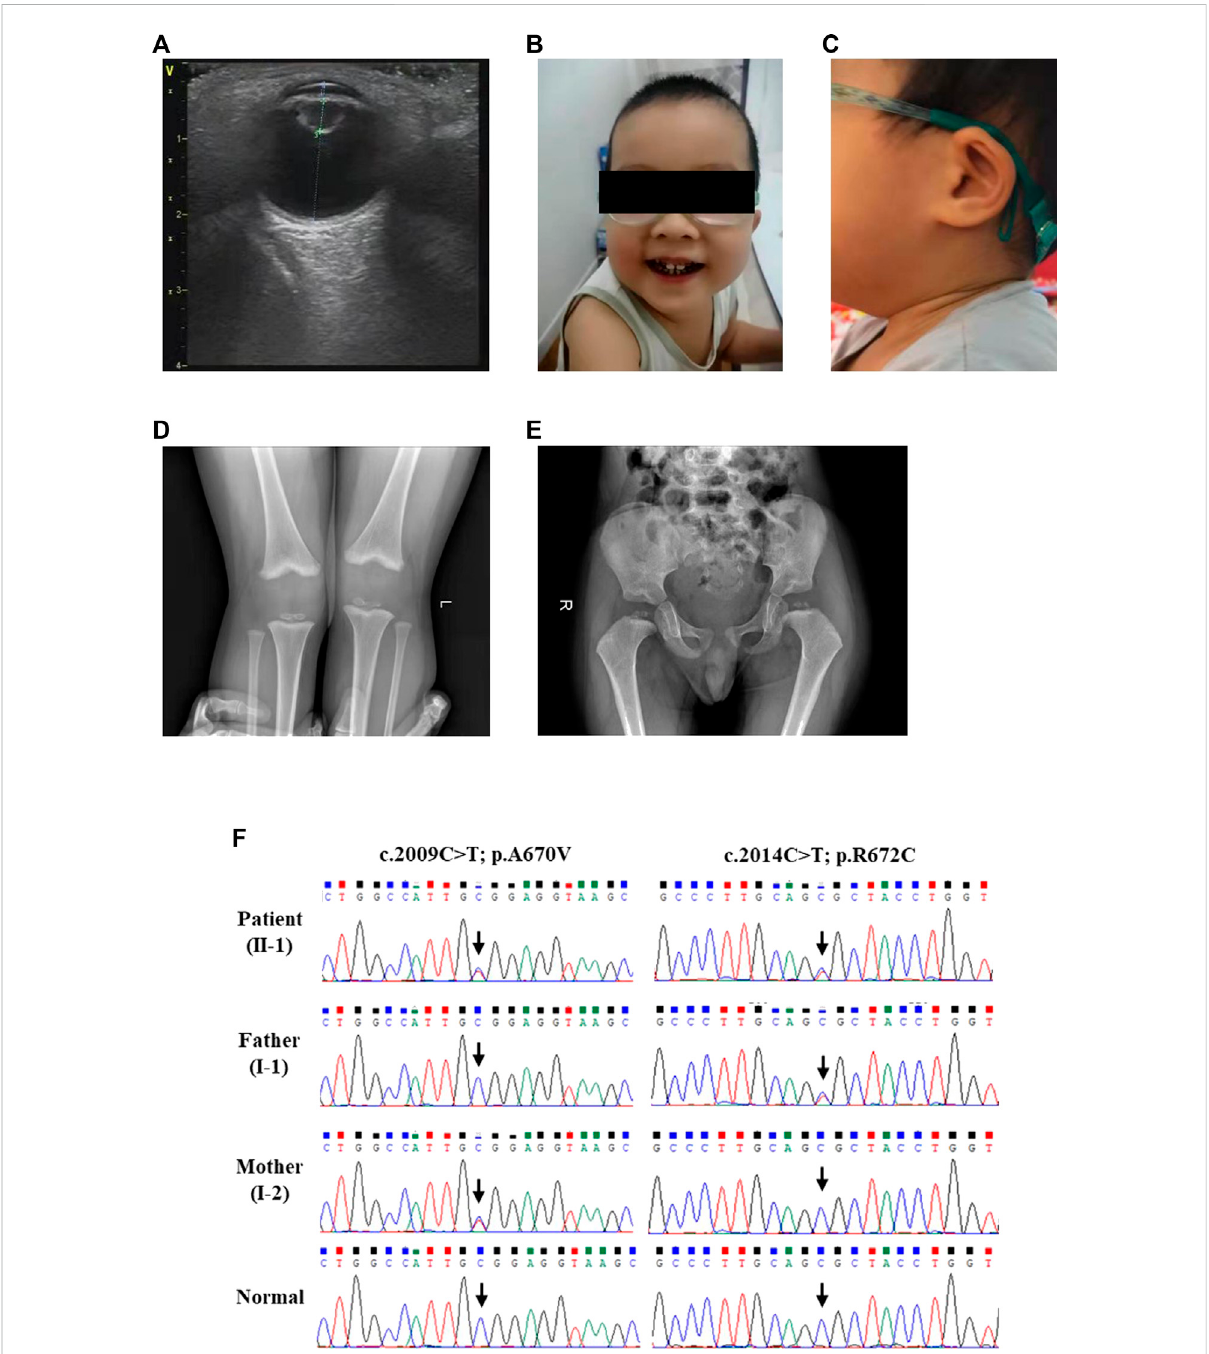
FIGURE 1 The clinical and sequencing data of this patient. (A) Ultrasonic examination of the patient ’ s eye. Physical features of this patient included (B) caries and (C) the auricles of both ears were small, and the contour was abnormally folded. (D) Skeletal radiography of the patient ’ s knees. (E) The pelvicradiographsofthepatient. (F) SangerDNAsequencingchromatogram detectedacompoundheterozygousmissense mutation(NM_004793: c.2009C > T/p.A670V and c.2014C > T/p.R672C) of LONP1 gene in the